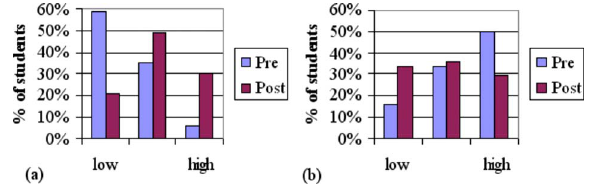
FIG. 4. (cid:1) Color (cid:2) Personal interest in physics in (cid:1) a (cid:2) PET and PSET and (cid:1) b (cid:2) calculus-based